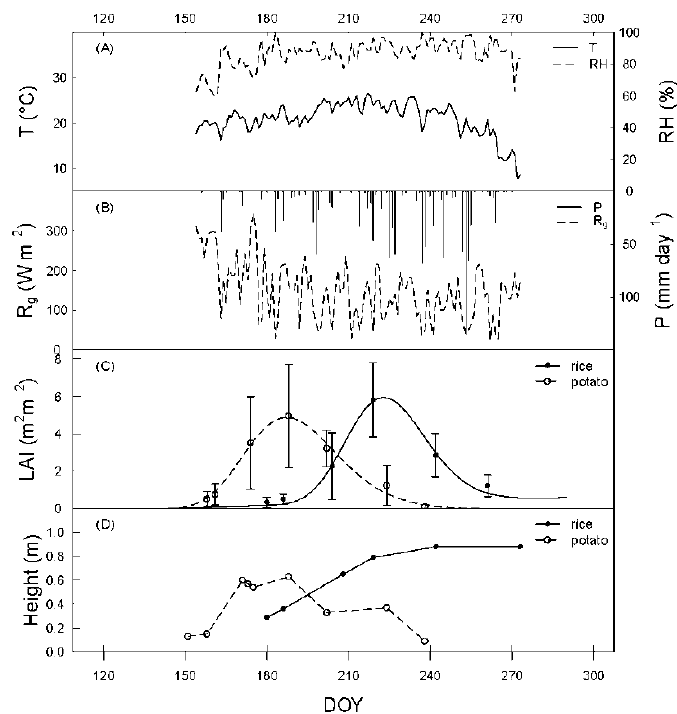
Figure 1. Meteorological conditions and vegetation development at the research sites, including daily mean air temperature ( T , solid line in A ), daily mean relative humidity (RH, dashed line in A ), daily sum precipitation ( P , solid line in B ), daily mean solar radiation ( R g , dashed line in B ), and leaf area index (LAI, dashed line representing potato and solid line representing rice in C with standard deviations as error bars), and plant height (dashed line representing potato and solid line representing rice in D ).